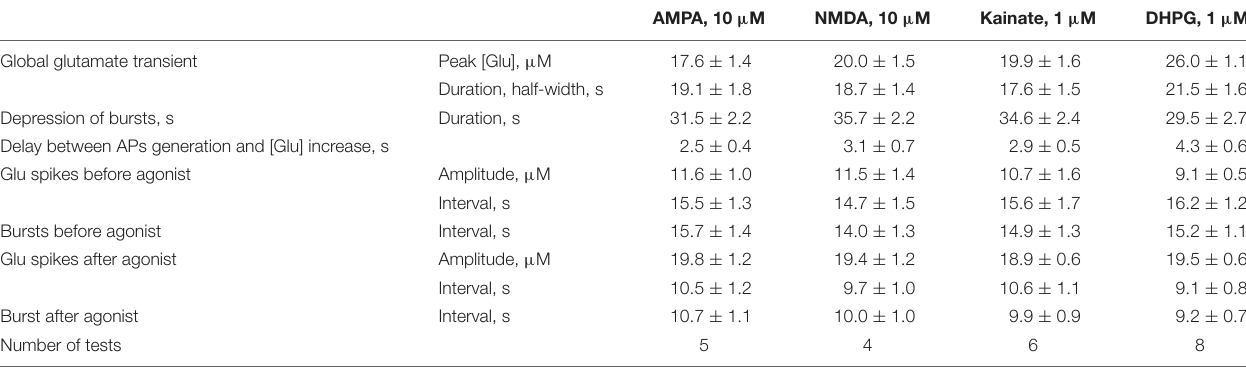
TABLE 2 | Characteristics of responses elicited by glutamate agonists in CA1 neurons in slices prepared from RTT animals.